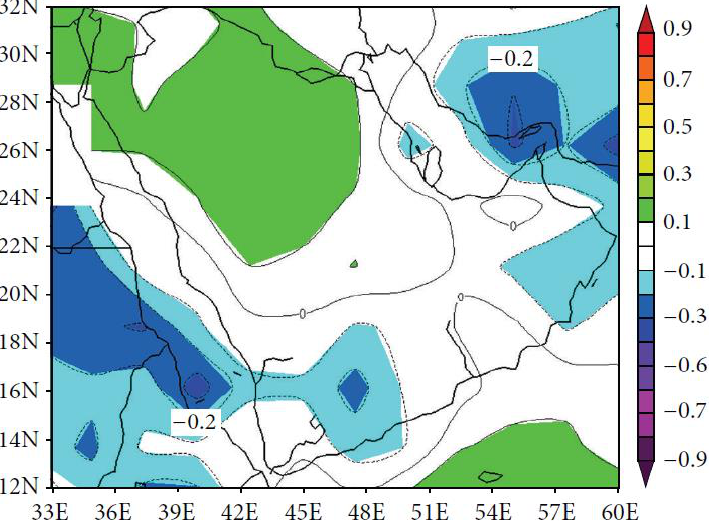
Figure 26 .The distribution of the linear correlation coefficient between surface CMAP precipitation (enhanced) over SA and ENSO through the period from 1979 to 2011 in summer season